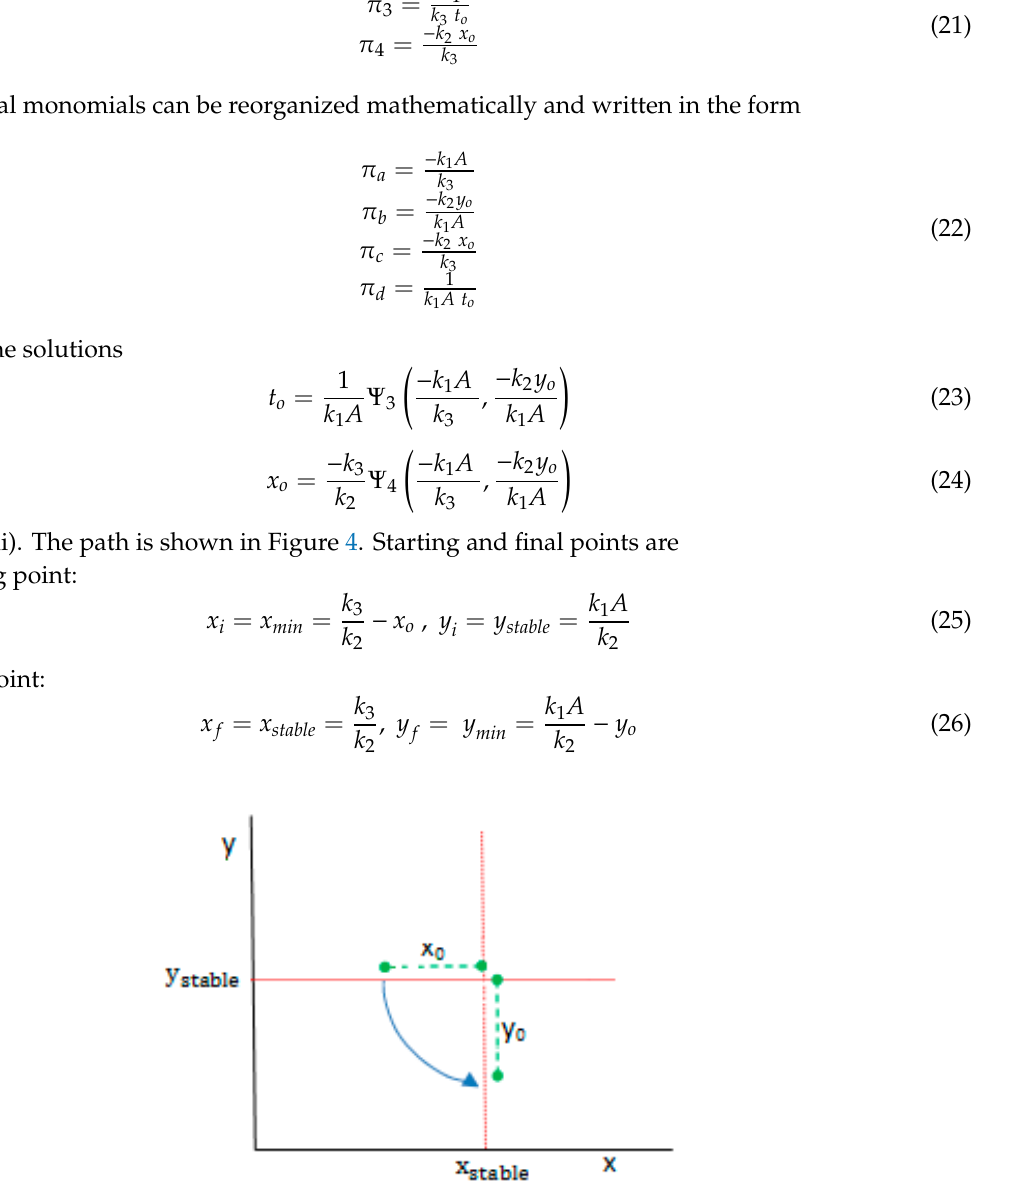
Figure 4. Starting and ending position of the path of the third quadrant.